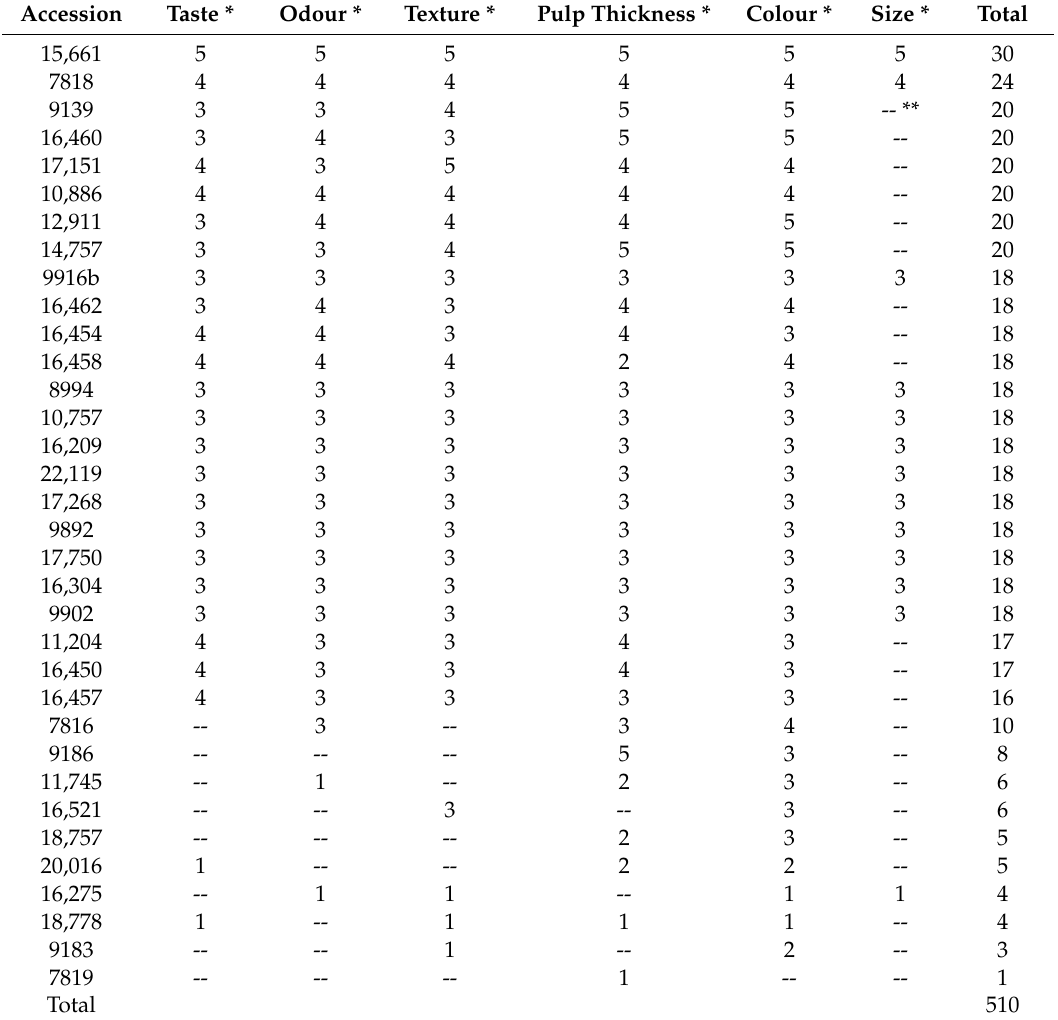
Table A1. Results of the participatory sensory evaluation for 34 selected accessions of Capsicum spp. CATIE. Costa